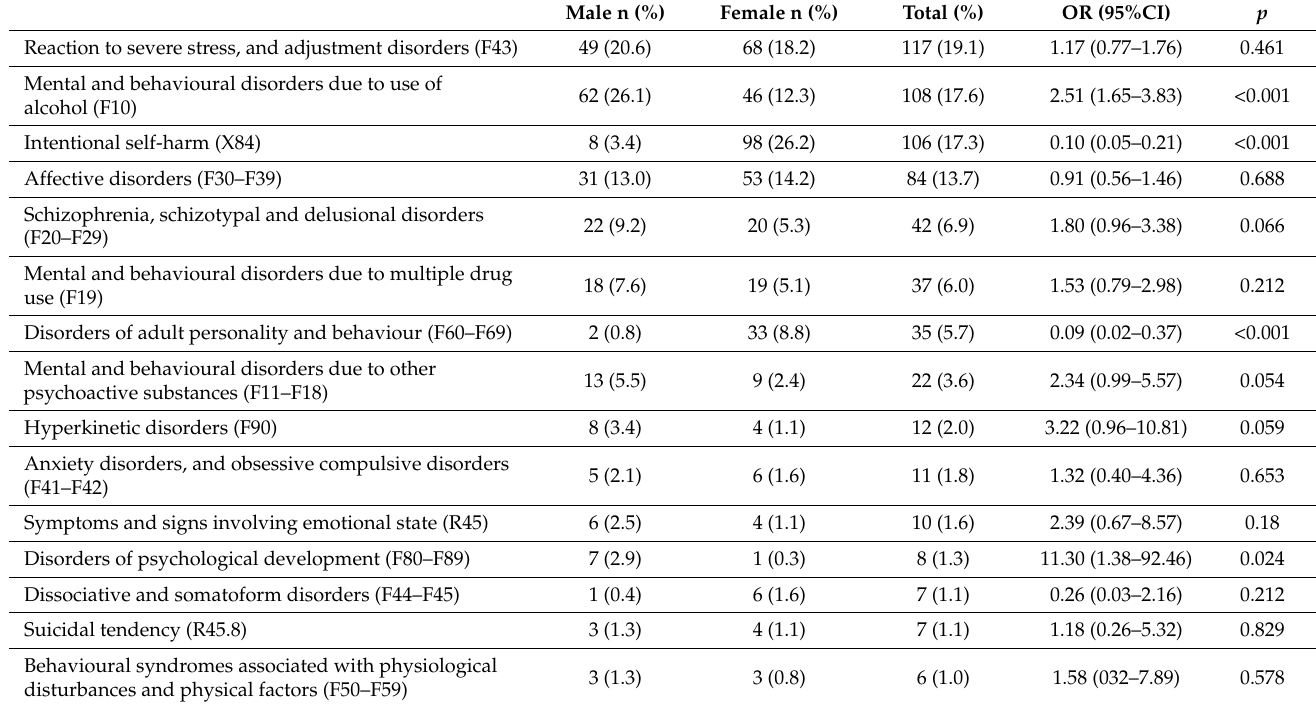
Table 1. Diagnosis groups according to